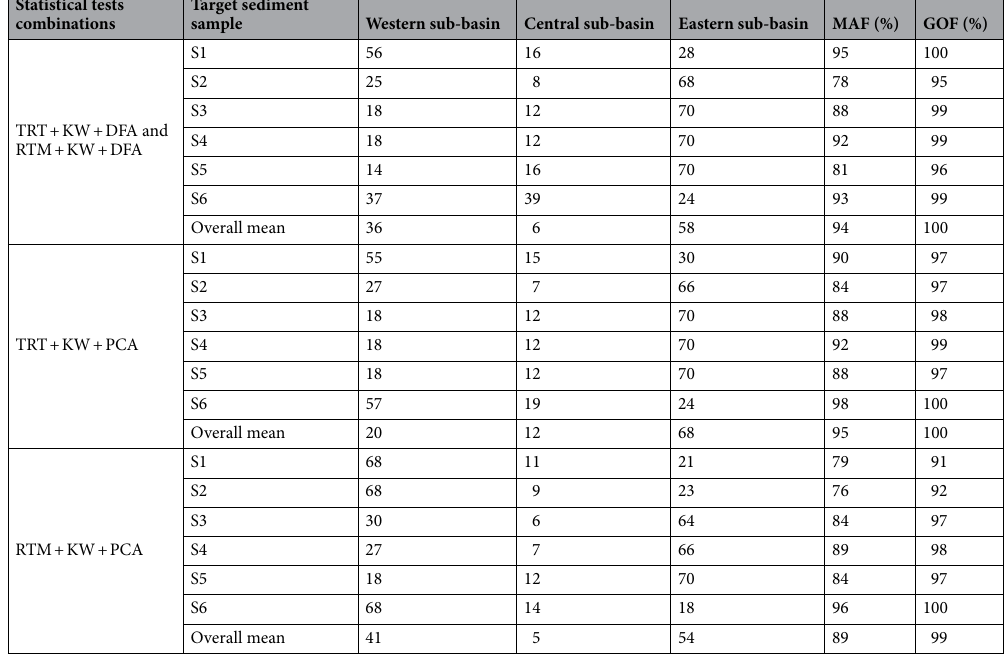
Table 4. The contributions of the three sub-basin spatial sources estimated by GLUE and the final composite signatures selected using different statistical tests and the corresponding values of MAF and GOF for predicting the measured geochemical tracer concentrations in the six target sediment samples